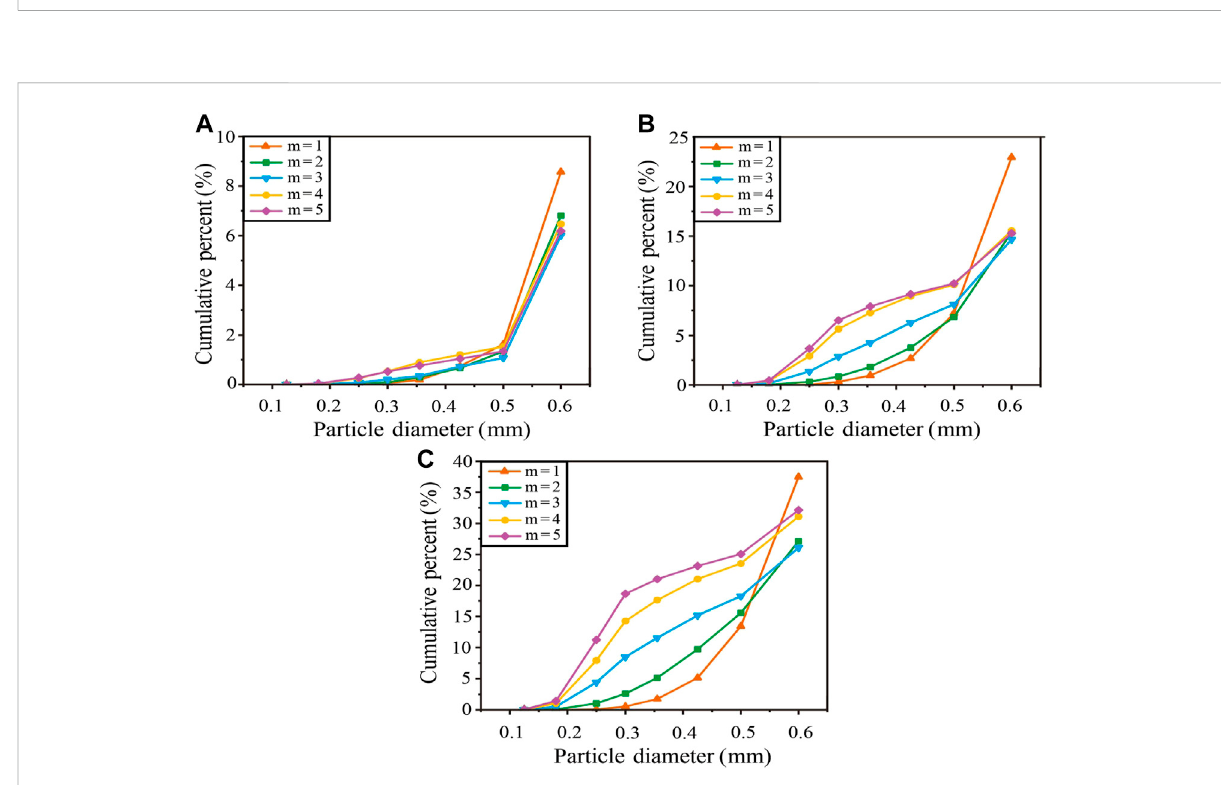
FIGURE 7 PSD of Group B: (A) Vertical stress = 20 MPa, (B) Vertical stress = 30 MPa, and (C) Vertical stress = 40